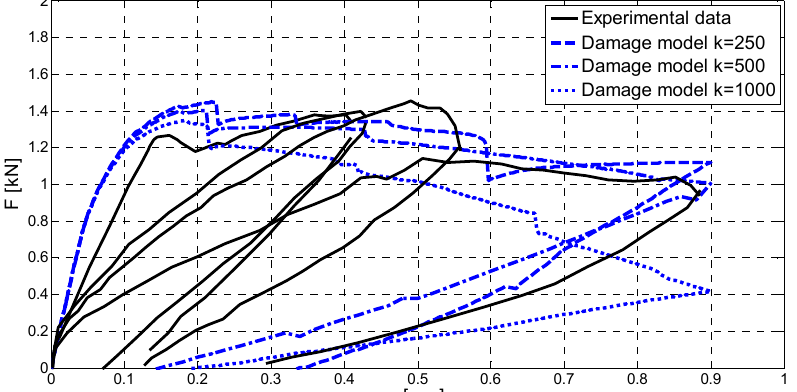
Figure 5: Response of the masonry arch: comparison between the experimental result data and numerical results obtained for different values of the k .